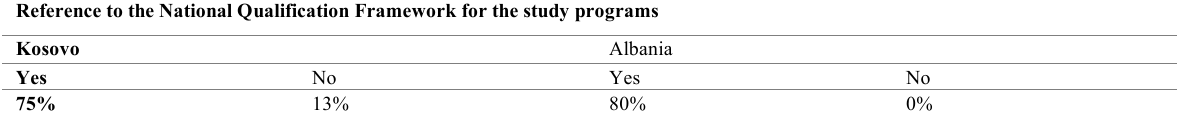
Table 2 : Second question for the HEIs in Kosovo and